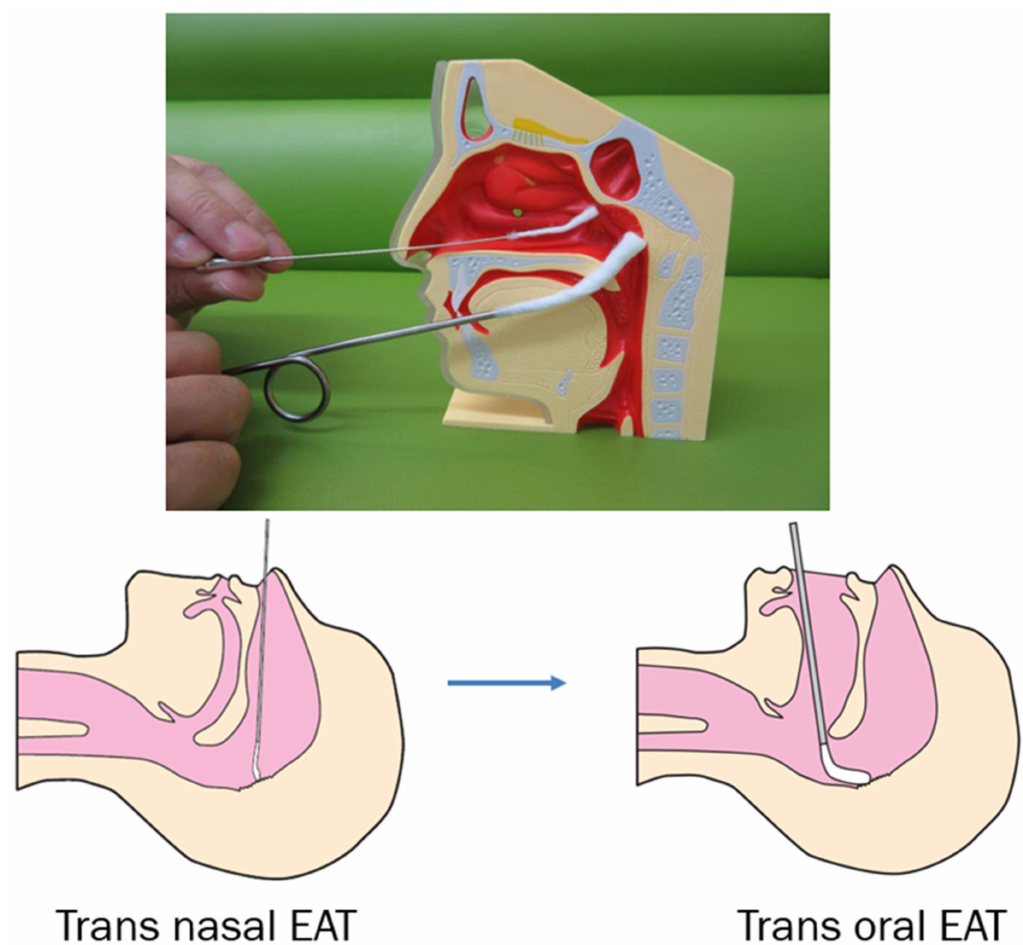
Figure 11. Schematic illustration of epipharyngeal abrasive therapy. A cotton swab soaked with 0.5% ZnCl 2 solution was inserted through both nostrils and rubbed approximately 30 times on each side. Next, the entire epipharyngeal wall was scrubbed using a pharyngeal swab soaked in 0.5% ZnCl 2